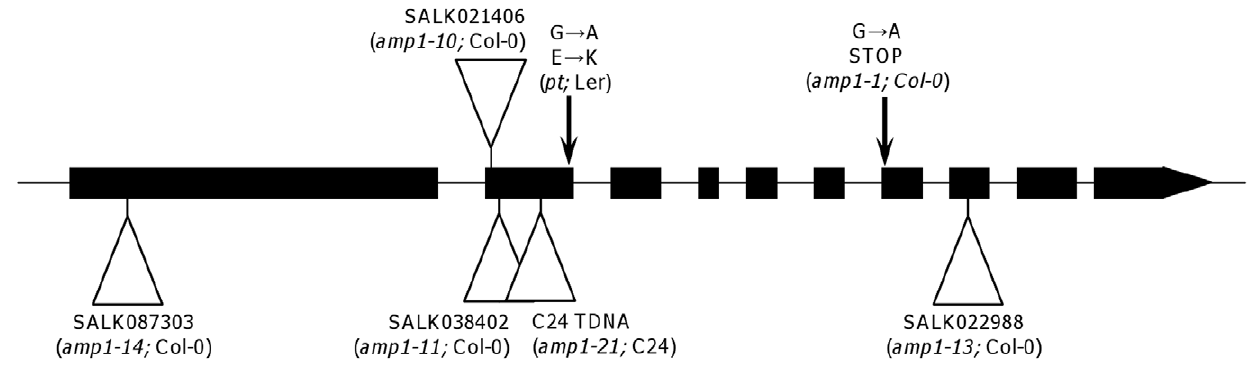
Figure 1. Positions of the mutations in AMP1 used in this work. The structure of the AMP1 gene is presented. Exons are shown as boxes, T- DNA insertion locations are indicated by triangles and the amp1-1 and pt mutations by arrows.